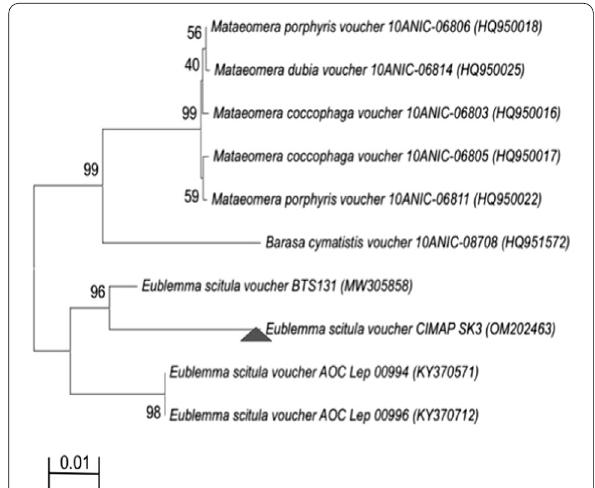
Fig. 2 The evolutionary history was inferred using the neighbor-joining method, and the sequences have been retrieved from NCBI database. The numbers at nodes show the level of bootstrap support based on data for 1000 replication. Bar, 0.01 substitutions per nucleotide position and numbers in parenthesis represent GenBank accession numbers. Evolutionary analyses were conducted in MEGA X. E. scitula voucher CIMAP SK3 is indicated by black triangle